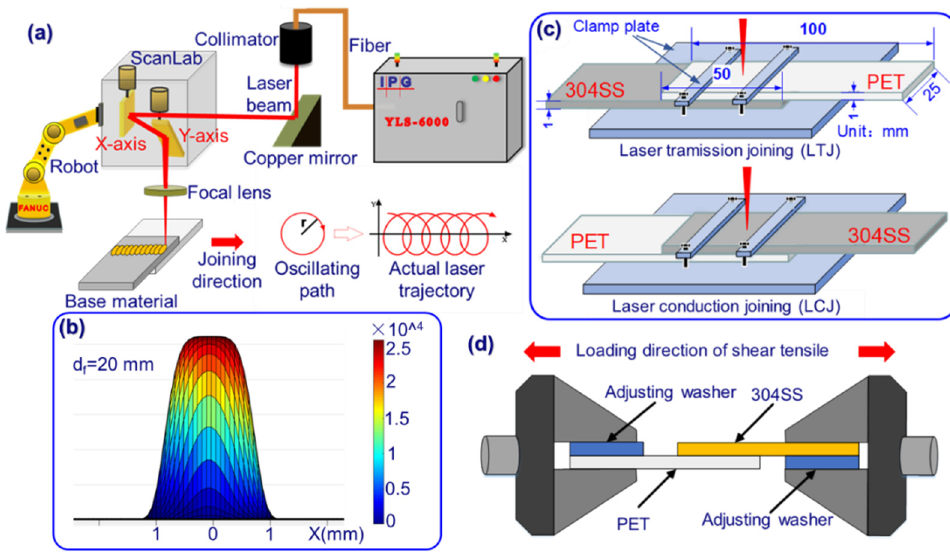
Figure 1. ( a ) Schematic diagram of experimental equipment, ( b ) energy distribution of spot at 20 mm of focus position, ( c ) clamping configurations corresponding to the two joining methods, ( d ) schematic diagram of composite joint tensile-shear test. Table 1. Physical properties of PET.